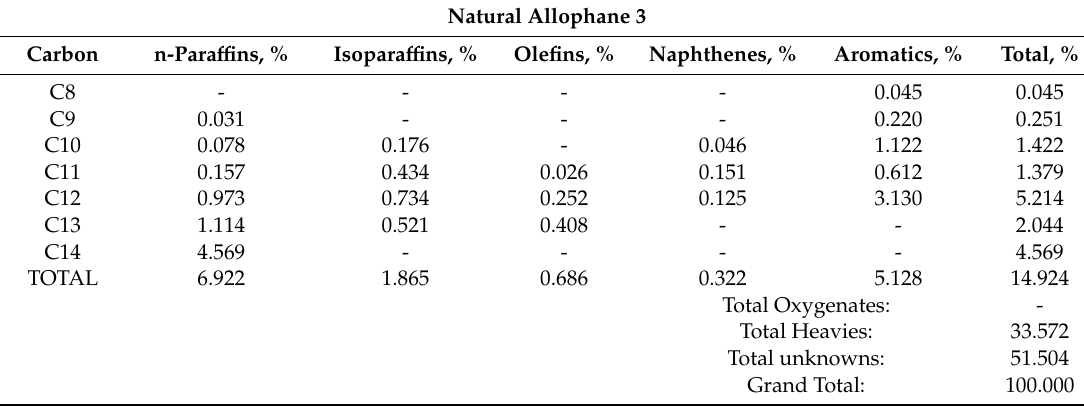
Table 24. Total composition results by group type and carbon number, as a percentage of the mass of natural allophane 3.